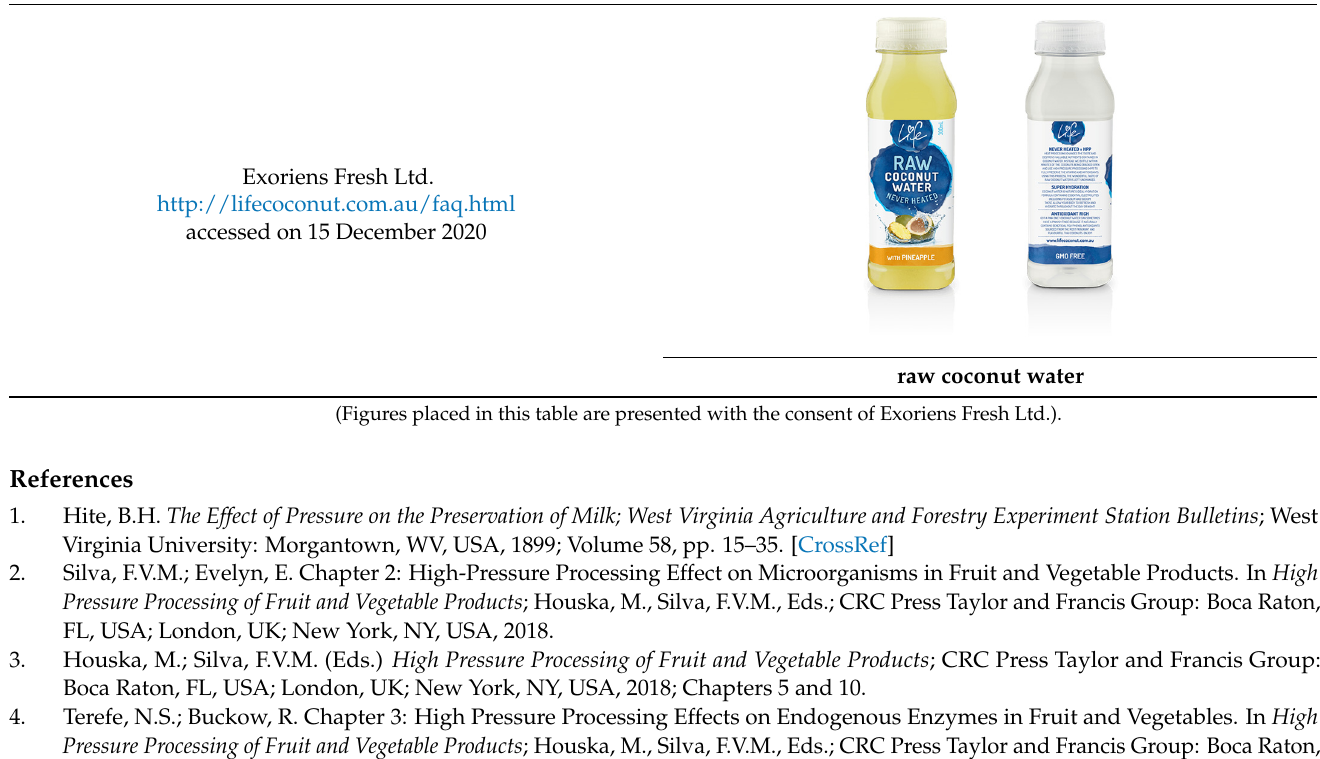
Table A15. High pressure treated products by the company Vegus Foods Ltd.